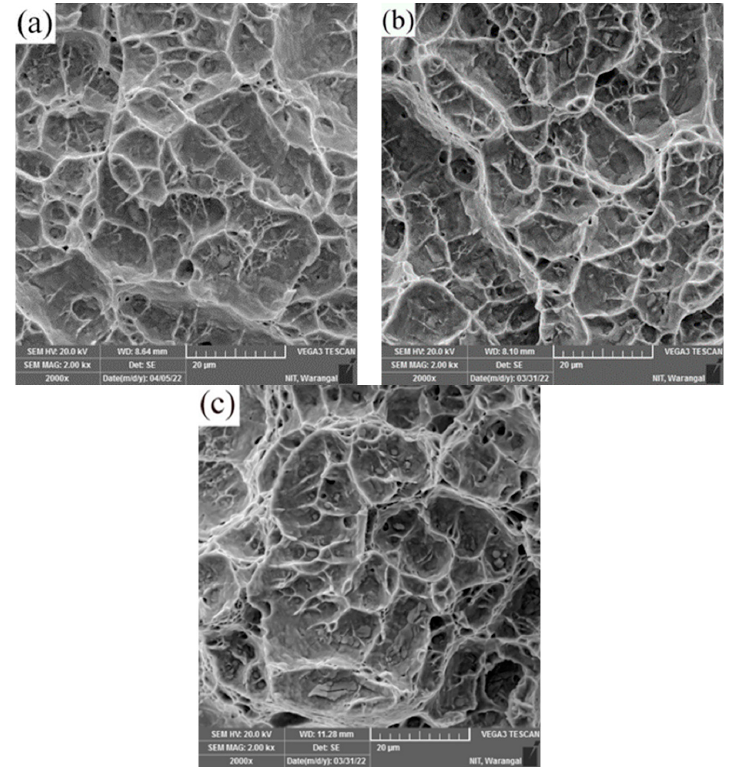
Figure 13. Tensile fracture morphology of dissimilar friction welds ( a ) AISI316L/IN718 ST, ( b ) AISI316/-IN718 STA, and ( c ) PWHT.